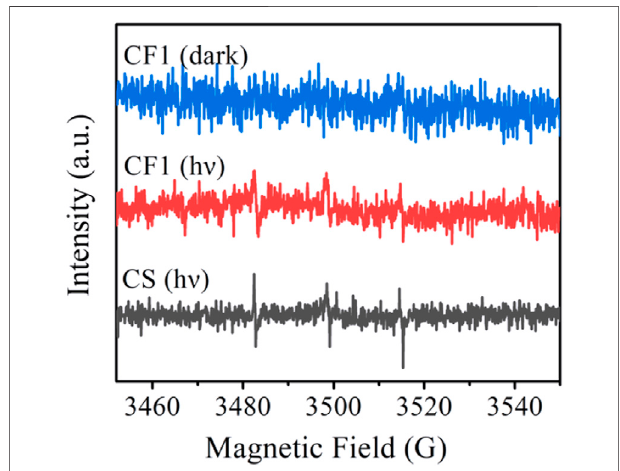
FIGURE 10 | EPR spectra of 1 O 2 captured by TEMP after CF1 was dispersed in water under dark and light for 10 min, and CS was dispersed in water under light for 10